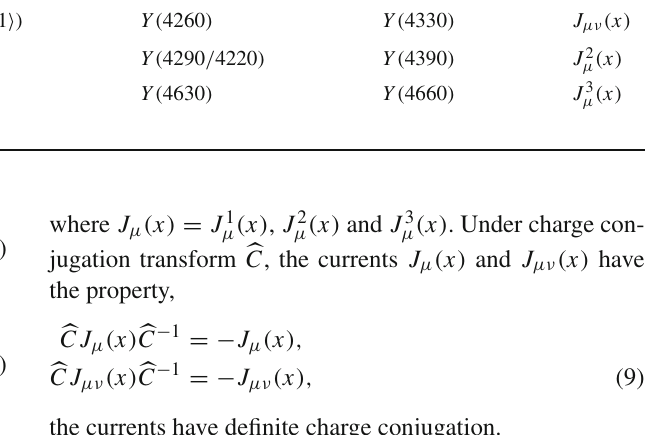
Table 2 The vector tetraquark states, possible assignments and the corresponding vector tetraquark currents, where the mixing effects are